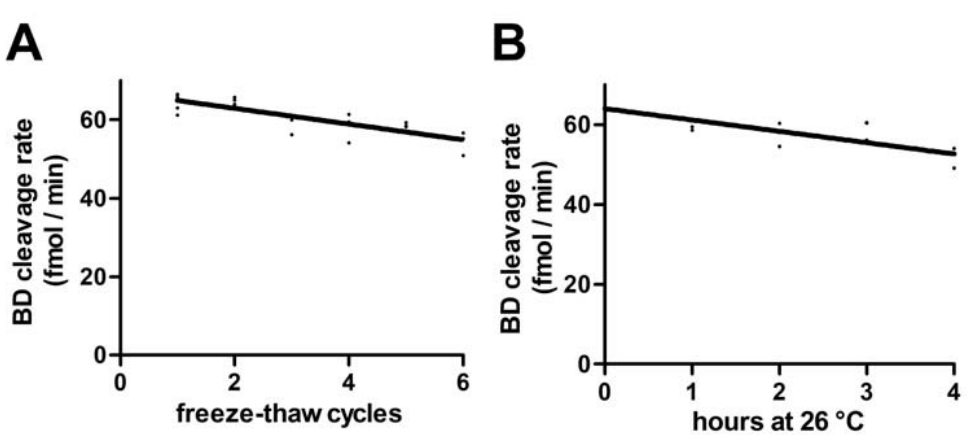
Figure 2. Ruggedness. ( A ) Aliquots of the same sample were frozen at − 20 °C and thawed up to 6 times. Each cycle of freezing and thawing resulted in a mean activity loss of − 3.1% (Pearson’s r = − 0.94). ( B ) Aliquots of the same sample were stored at 26 °C for up to 4 h and activities were compared with the RNase H2 assay. Mean loss of activity was − 4.4%/hour (Pearson’s r = − 0.91).